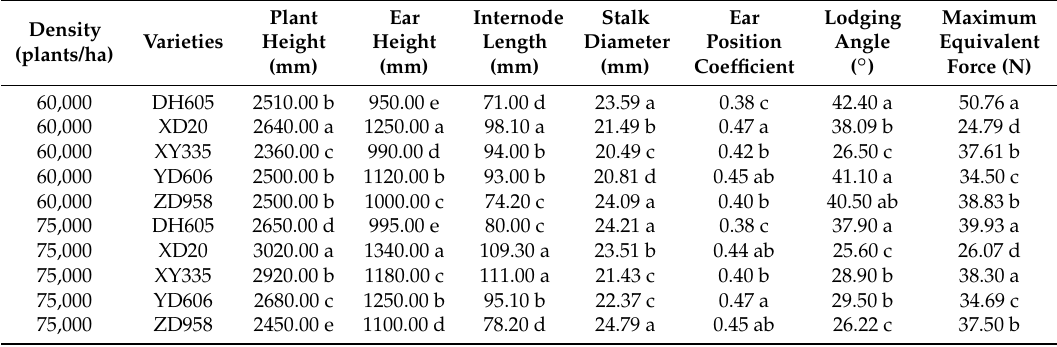
Table 1. The agronomic traits and stalk lodging properties from five corn varieties with two planting